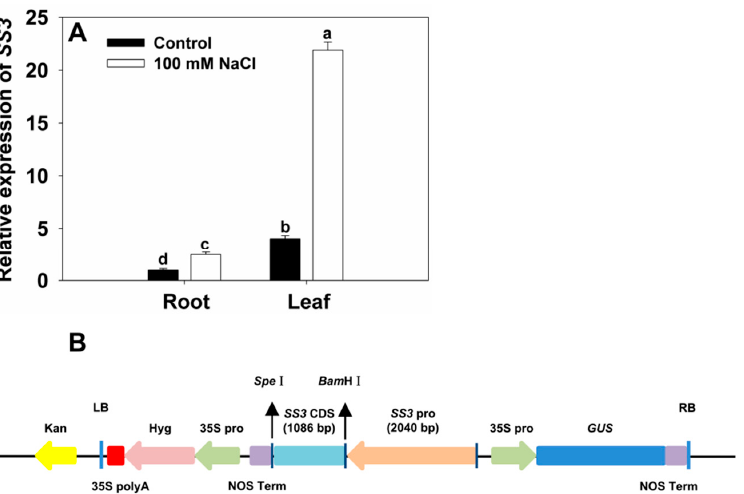
Figure 6. Effect of salt stress on the expression of SS3 , and construction map of SS3p:SS3 vector. ( A ) Relative expression levels of the SS3 gene in rice roots and leaves under normal and salinity stress. The abundance of SS3 transcript in the non-stressed roots was normalized to 1. The values are means ± SE of three replicates. Significant differences at p < 0.05 are indicated with different letters. ( B ) Construction map of SS3p:SS3 expression vector.